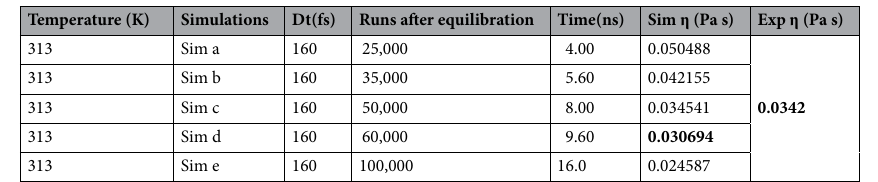
Table 5. Experimental results and the calculated viscosities results are listed at different timeperiods using MDS. Significant values are in bold.